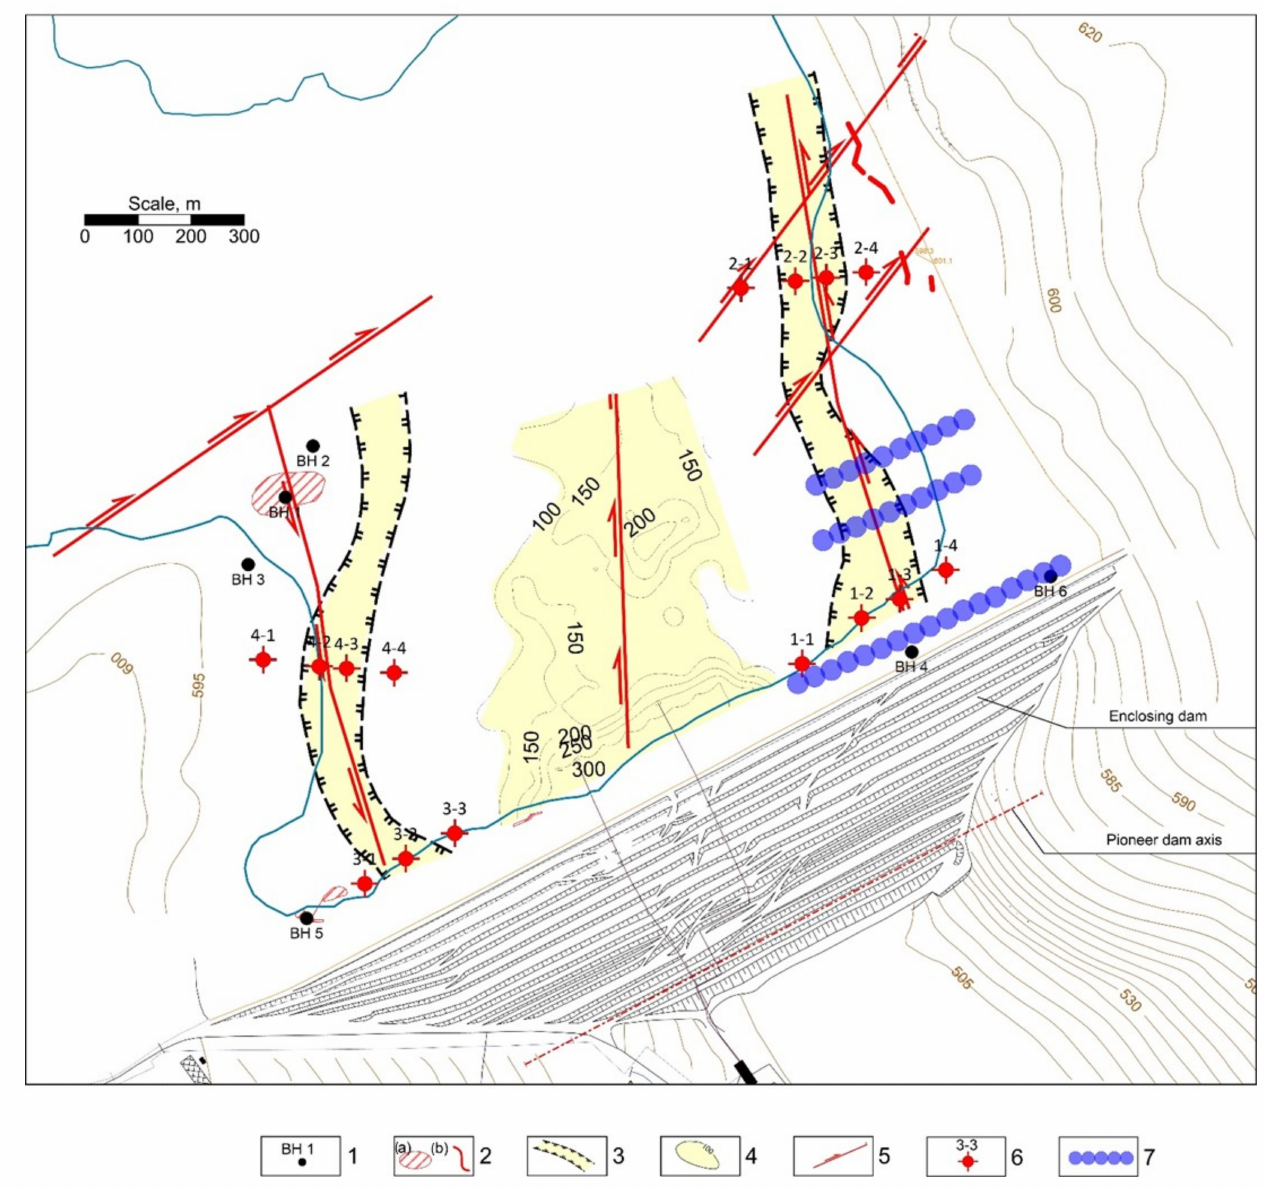
Figure 11. Layout of faults and filtration zones, as wells for injection of plugging composite. 1—wells; 2—dips (a) and cracks (b); 3—filtration zones in landfalls; 4—filtration zone at the base of the tailing dump and thawing depth; 5—faults; 6—recommended control wells; 7—wells for injection of plugging composite; blue line—contour of the tailings